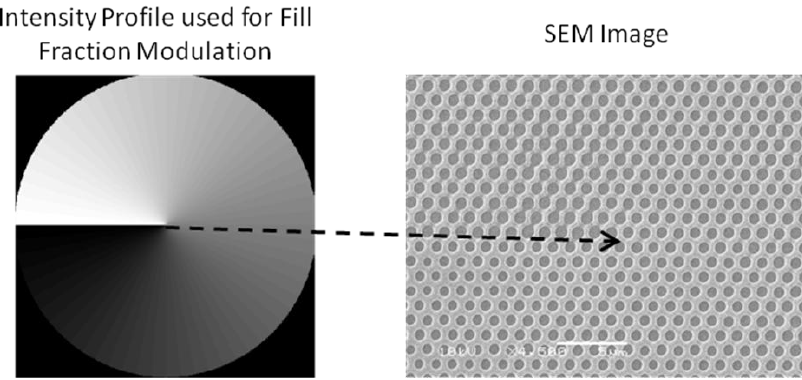
Figure 11. ( Left ) Desired analog intensity; ( Right ) SEM of an hexagonal grating with an azimuthal fill fraction